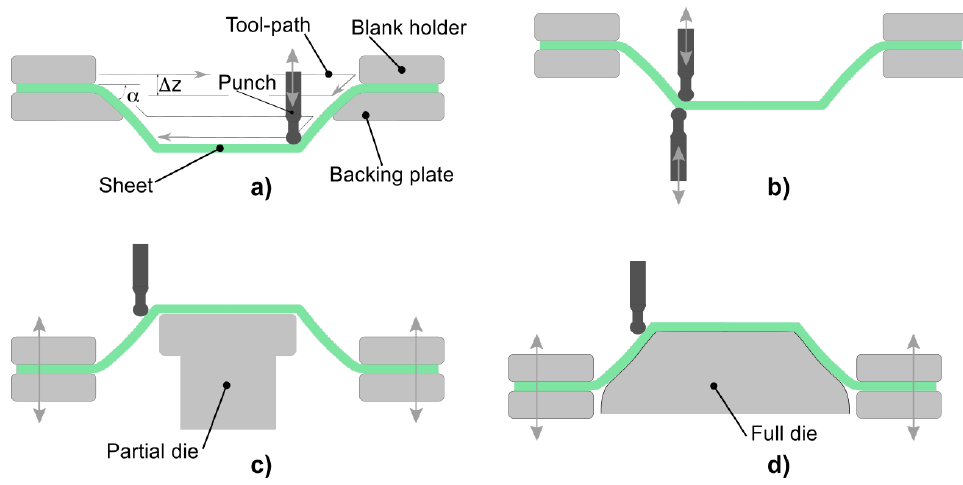
Figure 1. Main incremental sheet forming (ISF) techniques. ( a ) Single point incremental forming; ( b ) Two point incremental forming; ( c ) Double-sided incremental forming with partial die; ( d ) Double-sided incremental forming with full die.